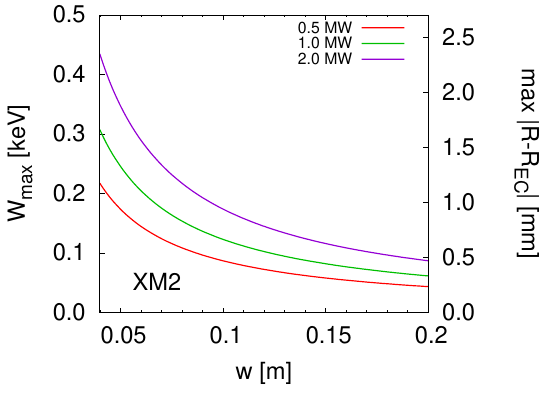
Figure 7. Radial energy profile for XM2 for N (cid:107) = 0 , 0 . 3 and P EC = 1 MW in ITER ( R EC 2 = R EC at half field B 0 = 2 . 65 T.)